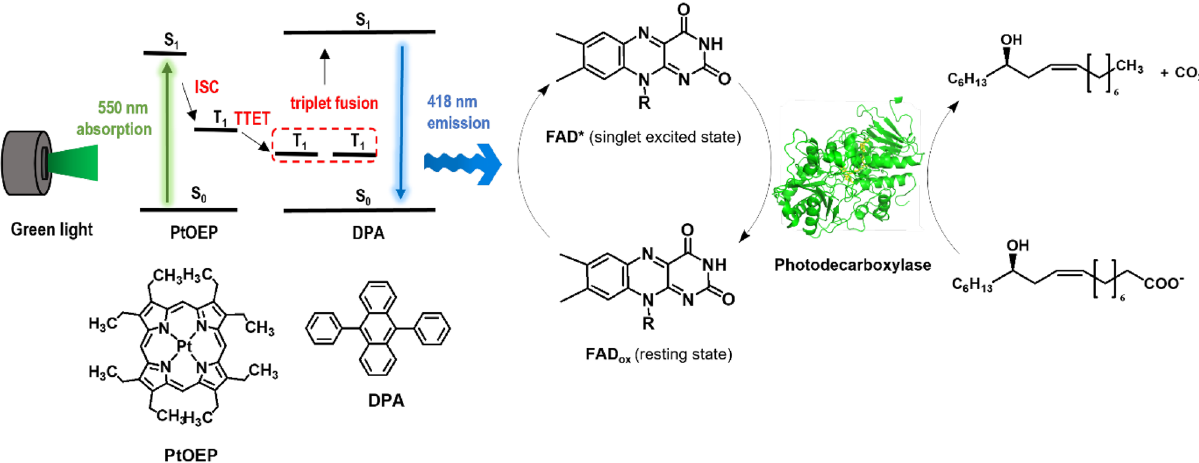
Figure 1. Overall concept of triplet–triplet annihilation-based photon-upconversion (TTA-UC) for light- driven enzyme catalysis. The TTA-UC allows conversion of long wavelength ( λ = 550 nm) to short wavelength light ( λ = 418 nm), which activates FAD in the enzymes for catalysis (see the Figures S1 and S2 for details). PtOEP: platinum(II) octaethylporphyrin, DPA: 9,10-diphenylanthracene, ISC: intersystem crossing, TTET: triplet–triplet energy